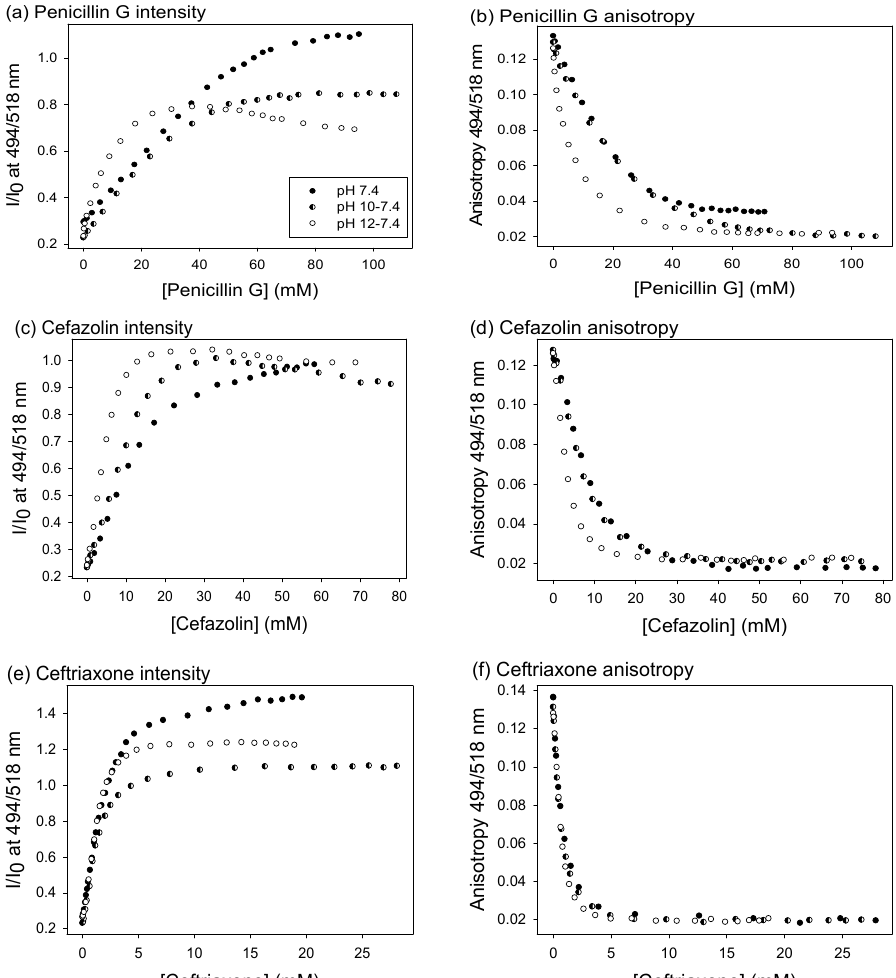
Figure 3. Fluorescence emission profiles from the titration of penicillin G ( a , b ), cefazolin ( c , d ), and ceftriaxone ( e , f ) into [calcein•PAMAM] complex in solutions prepared at different pH (7.4, 10, and 12) and brought back to pH 7.4, corresponding to different levels of β -lactam ring hydrolysis. Left: fluorescence emission; right: fluorescence anisotropy. [calcein] = 6.36 μ M, [PAMAM G5] = 2.13 μ M, excitation: 494 nm, emission: 518 nm. Performed in 50 mM aqueous HEPES buffer at pH 7.4, T = 25 °C.